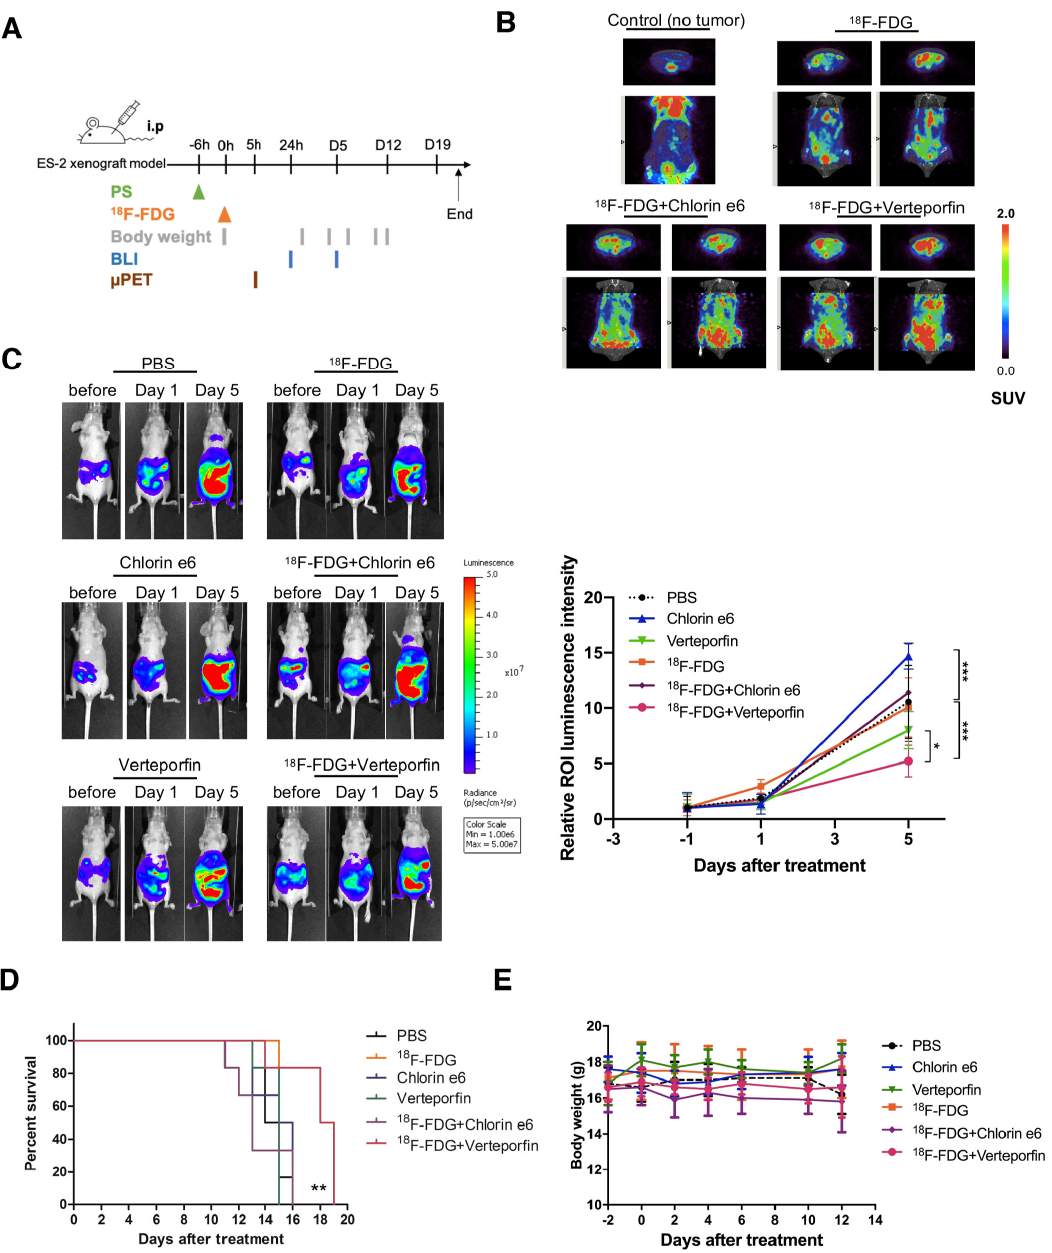
Figure 3. In vivo effect of CR-induced photodynamic therapy on ovarian cancer. ( A ) Schematic diagram for CR-PDT. Tumor bearing-mice were given intraperitoneal injection of Chlorin e6 or Verteporfin. Six hours later, mice were received 37 MBq of 18 F-FDG intraperitoneally. ( B ) Biological uptake in tumor-bearing mice at 5 h after 18 F-FDG injection. Representative images showing increased uptake in tumor-bearing mice but no difference among three groups that received 18 F-FDG. ( C ) Evaluation of the effect of CR-PDT by optical bioluminescence image. Tumor burden in the peritoneal cavity was monitored at indicated time points. Representative bioluminescent images and quantification showing the combination of 18 F-FDG-emitted CR and Verteporfin suppressed tumor growth in ES2-luc-bearing mice. Data represent mean ± SD ( n = 5–6/group). * p < 0.05, ** p < 0.01, *** p < 0.001 by Student’s t -test. ** p = 0.0071, PBS versus 18 F-FDG + Verteporfin; ** p = 0.016, Verteporfin versus 18 F-FDG + Verteporfin; ** p = 0.004, 18 F-FDG versus 18 F-FDG + Verteporfin; ** p = 0.0099, 18 F-FDG + Chlorin e6 versus 18 F-FDG + Verteporfin; ** p = 0.028, PBS versus Chlorin e6 by Student’s t -test. ( D ) Kaplan–Meier survival curves representing the percentage of animals alive at the indicated time point after treatment. ** p = 0.0062, PBS versus 18 F-FDG + Verteporfin; * p = 0.0197, Verteporfin versus 18 F-FDG + Verteporfin; * p = 0.0154, 18 F-FDG versus 18 F-FDG + Verteporfin by Log-rank test. * p < 0.05, ** p < 0.01 (n = 6 mice per group). ( E ) The body weights of mice were recorded during the period of monitoring. Data are mean ± SD (n =